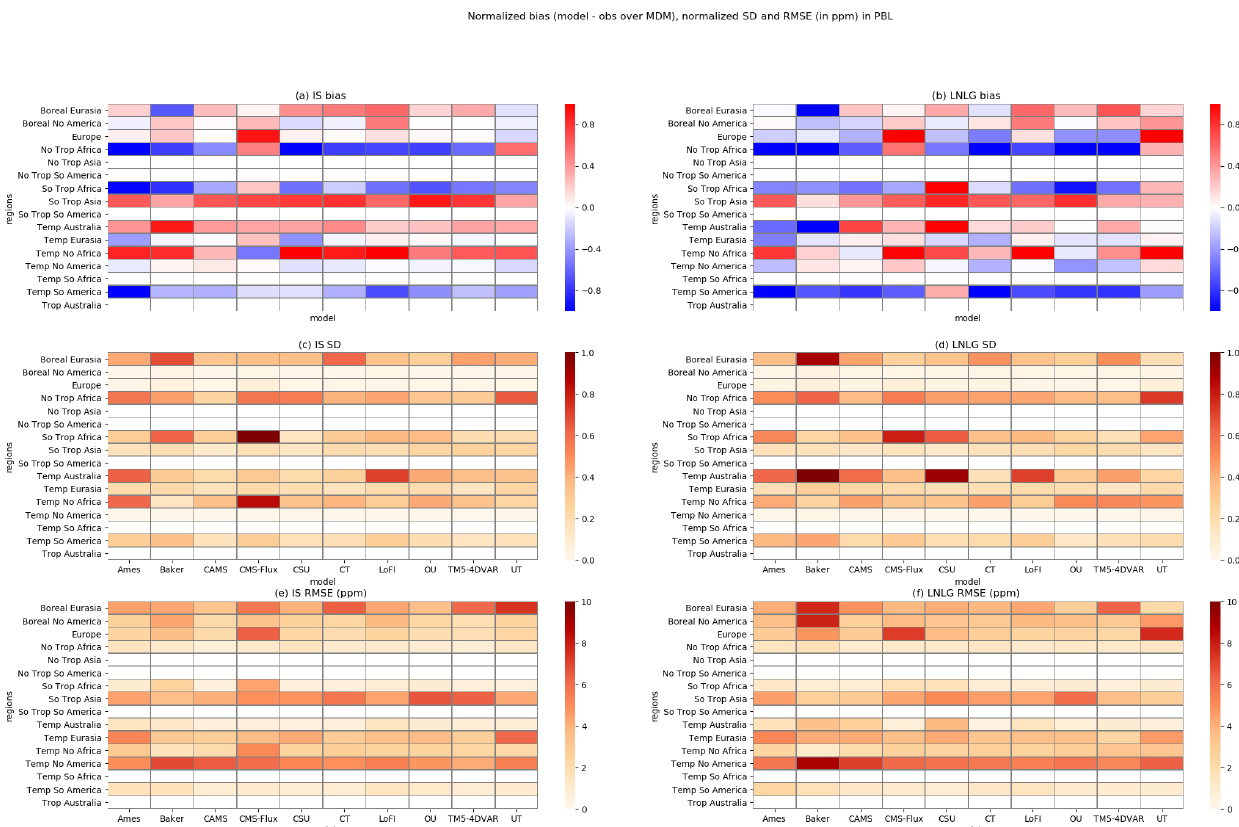
Figure 15. Same as Fig. 14 but for the MIP regions. No: northern; So: southern.